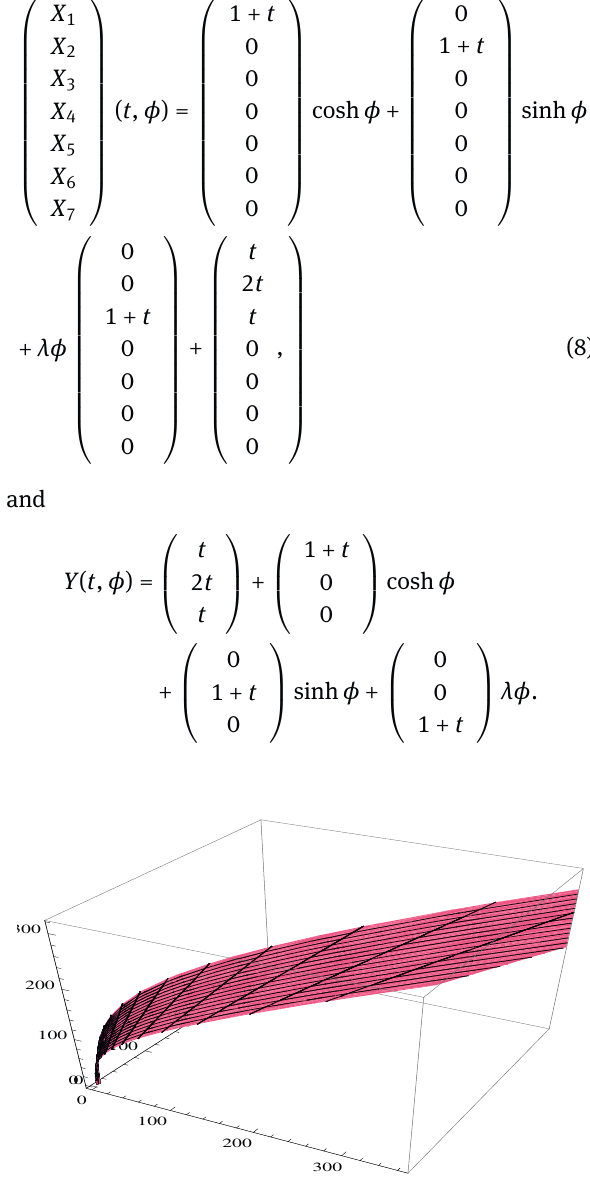
Fig. 1: A piece of two dimensional kinematic surfaces foliated by a homothetic motion of a Lorentzian circular helix in axonometric